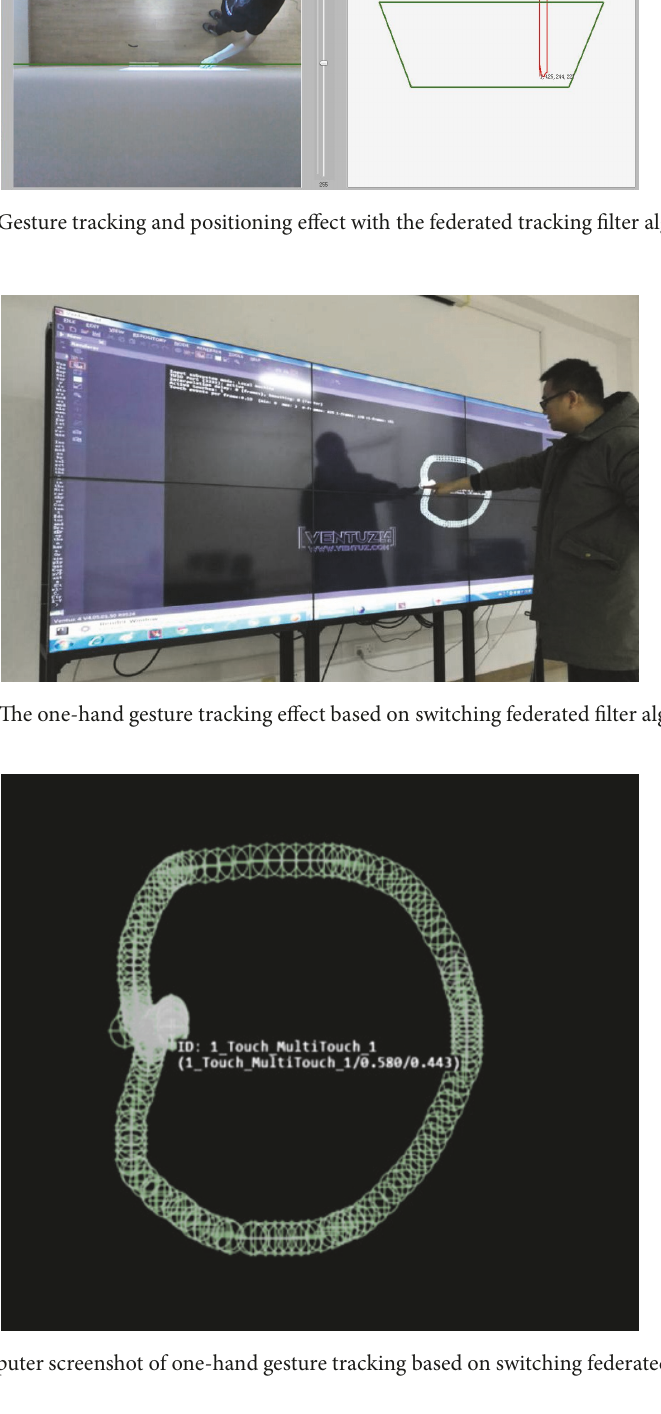
tracking effect based on Cam-shift algorithm, and Figure 8 is the corresponding computer screenshot for Figure 7.